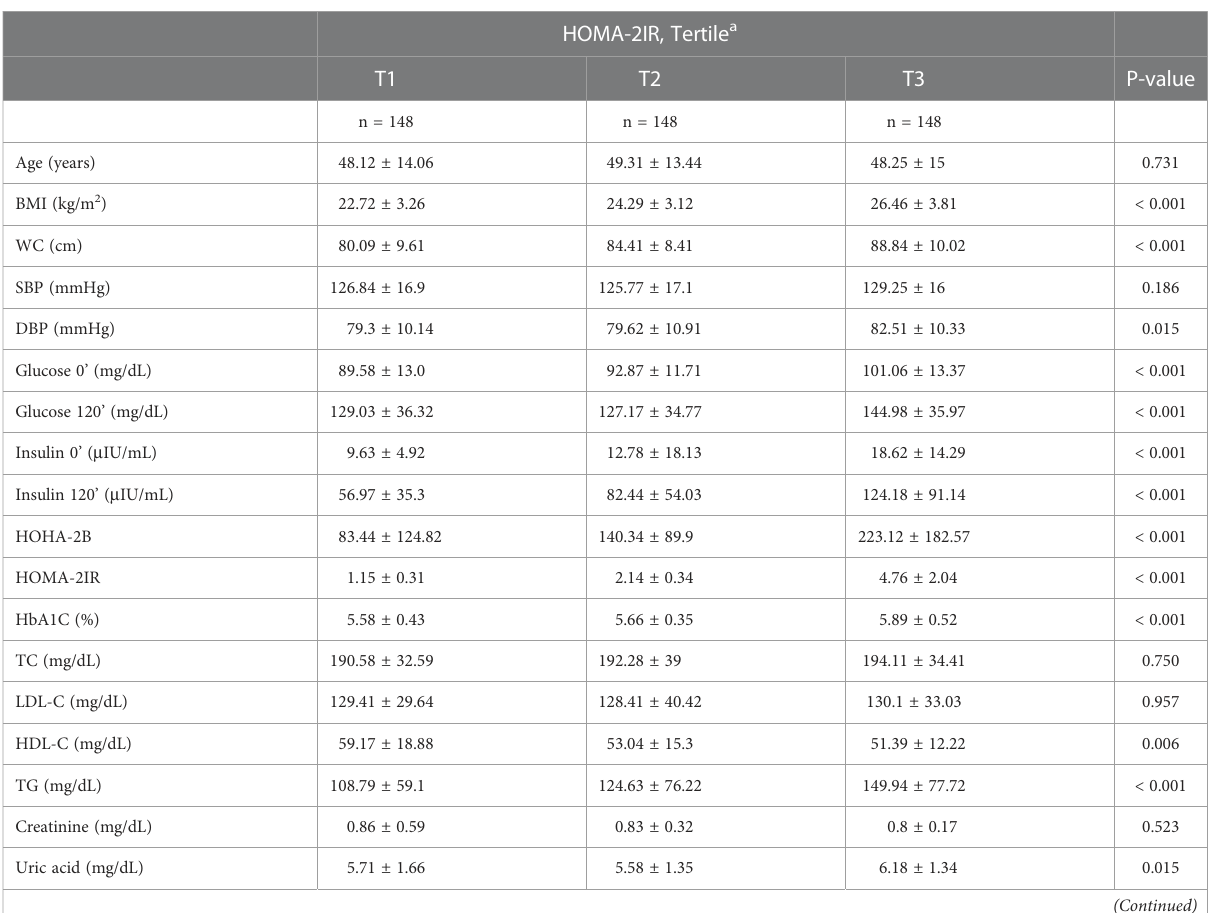
TABLE 2 Anthropometric and biochemical data of the participants (n =